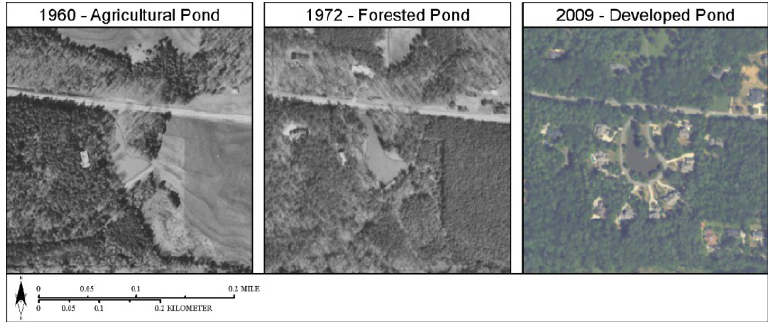
Figure 6. Example of land cover modification adjacent to a small reservoir. Adjacent land cover changes from agricultural, to forested, to developed.